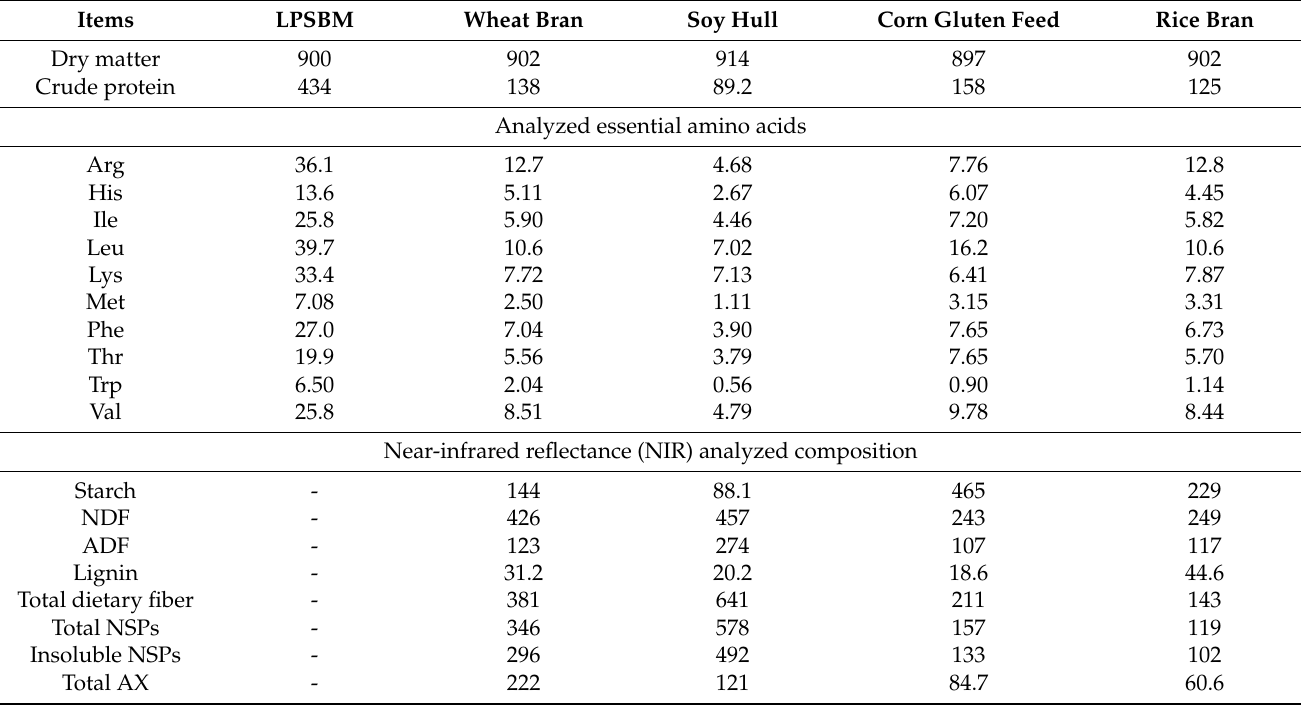
Table 1. Analyzed composition (g/kg) of the test feedstuffs.